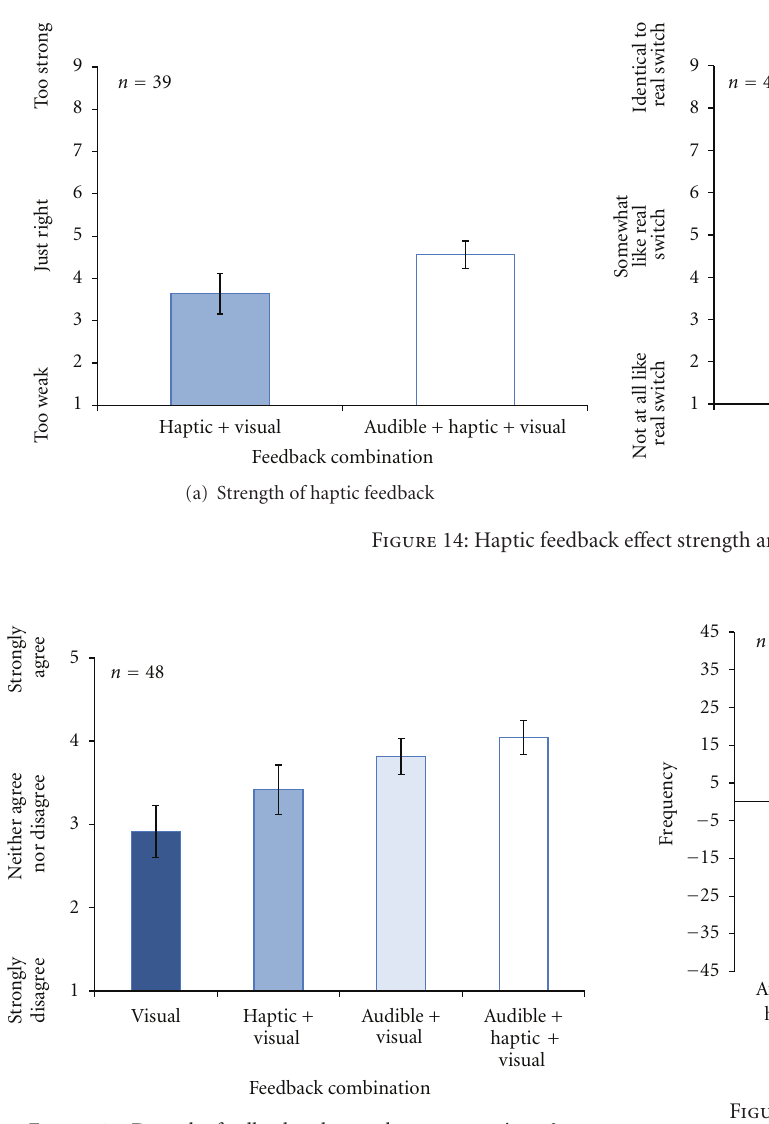
Figure 15: Does the feedback enhance the user experience?.